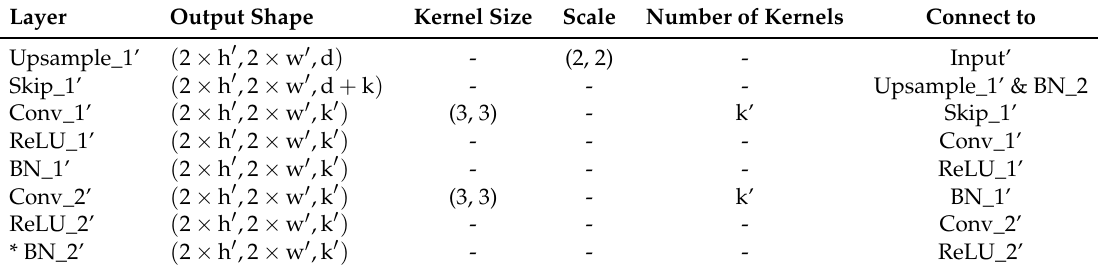
Table 2. Configuration of conv & upsample